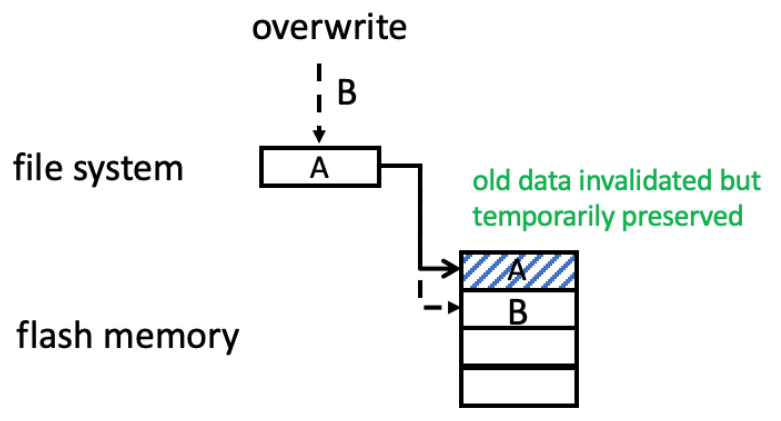
Figure 1. The out-of-place update in flash memory. When data A is overwritten by data B in the file system, data B will be placed on another flash page, and data A will be invalidated without actually being deleted from its holding flash